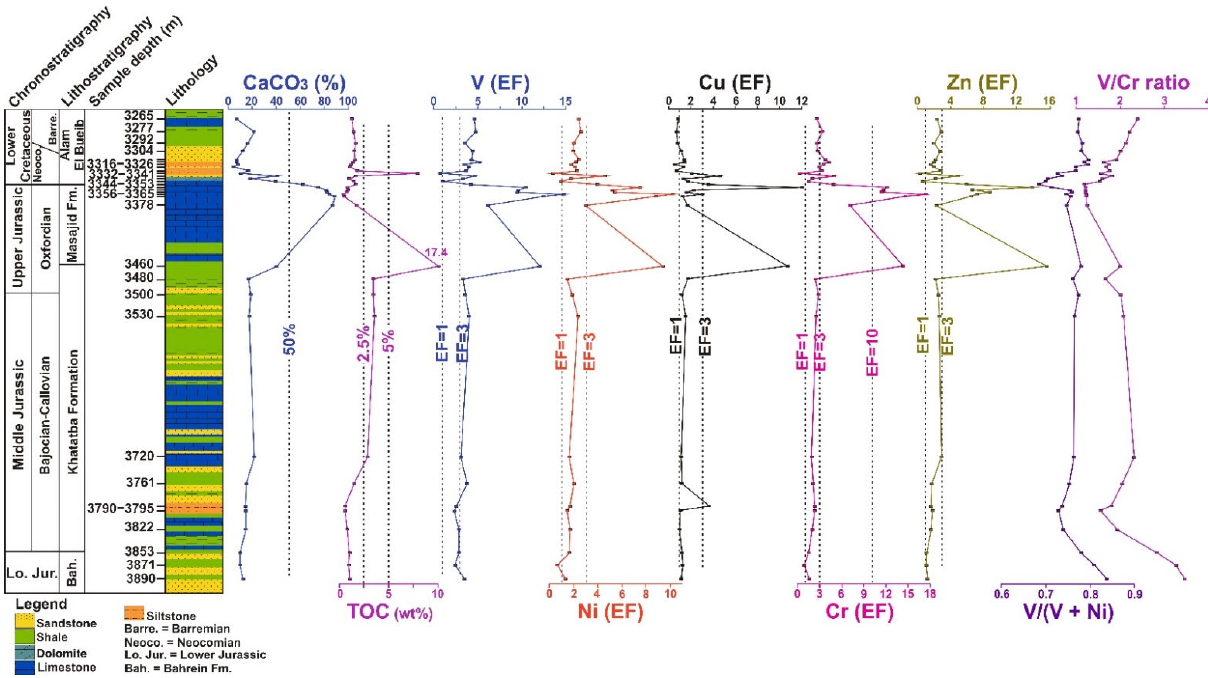
Figure 3. Chemostratigraphic distribution of TOC and enrichment factors of redox ‐ sensitive trace elements and ratios of V/(V + Ni) of the Jurassic–Lower Cretaceous sediments from the Almaz ‐ 1 well, Shushan Basin. The V/(V + Ni) and V/Cr ratios were smoothed with a 3 ‐ point moving average.